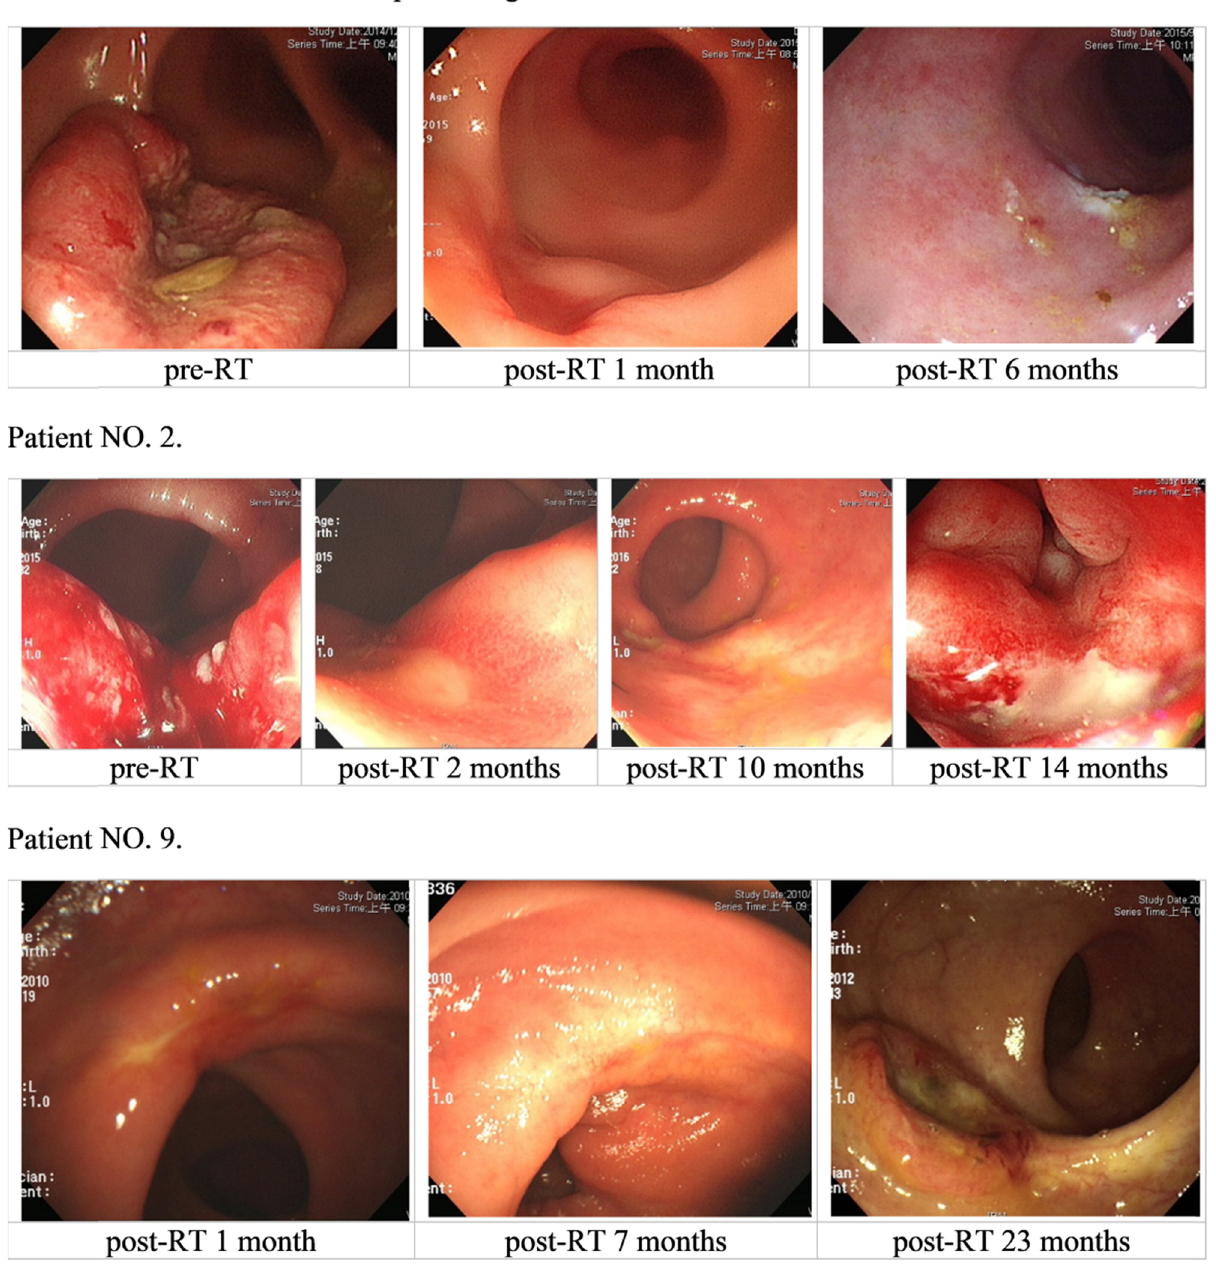
Figure 5: Colonoscopy fi ndings in patients with tumor regrowth after applying the W&W